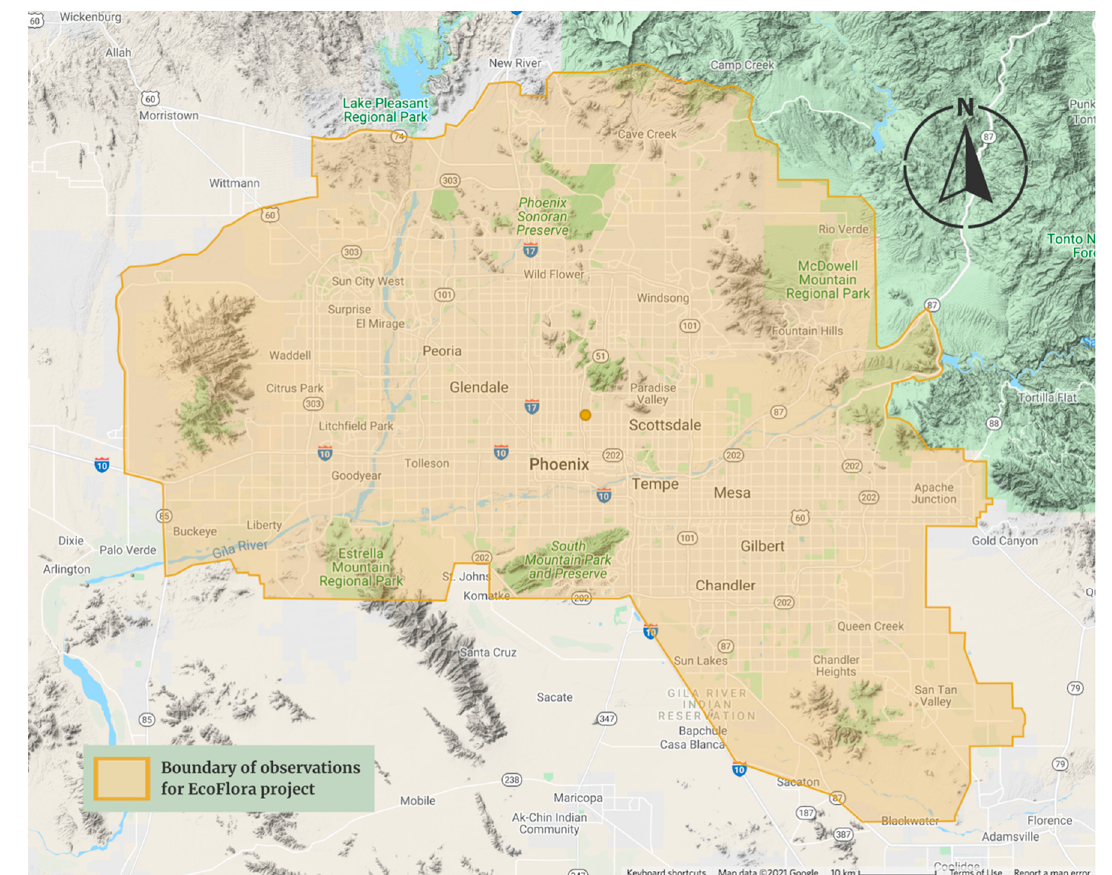
Figure 1. EcoFlora project boundary created with iNaturalist, using Google Maps data. The project collects data on urban biodiversity through iNaturalist (https://www.inaturalist.org/ (accessed on 11 January 2022)), a free web-based platform